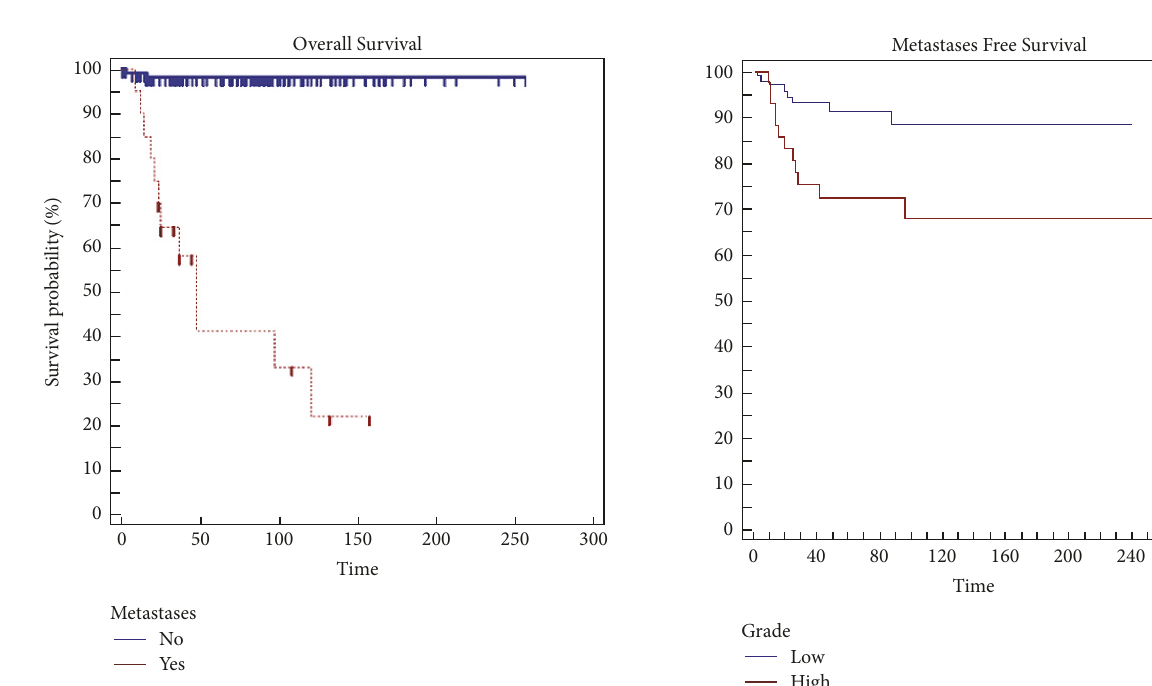
Figure 3: Metastasis is a high significant risk factor ( 𝑝 < 0,0001) in overall survival (OS). Figure 4: Grading is a significant risk factor ( 𝑝 = 0,0055) in metas- tasis-free survival